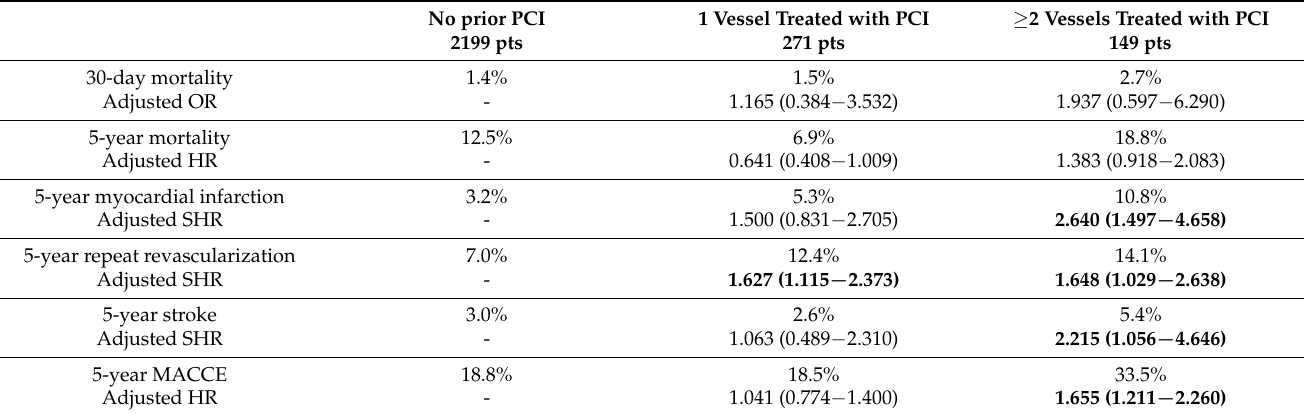
Table 4. Crude rates and adjusted risk estimates of outcomes in the study